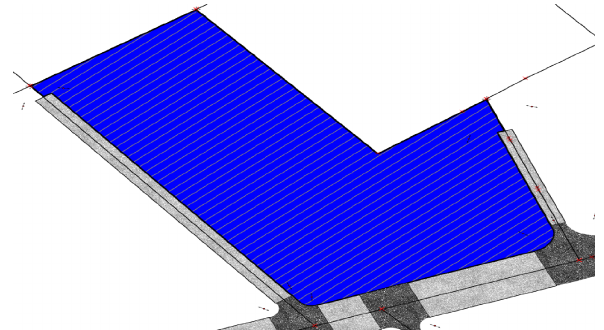
Figure 11: The blocks are generated even when some parts of the street network have not been